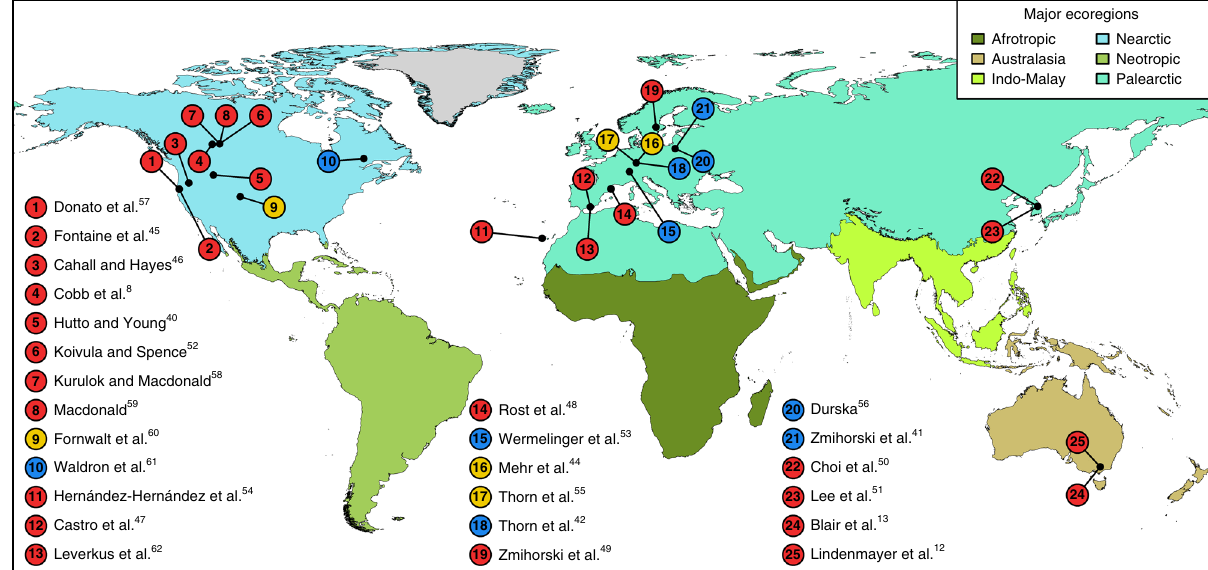
Fig. 2 Location of studies included in the present analysis. Each study provided species-by-plot abundance matrices for salvage-logged and unlogged, naturally disturbed forest plots. Disturbance types are indicated by different symbol colors (red: wild fi res, blue: windstorms, yellow: insect outbreaks; see Supplementary Table 1 for details and references). Background colors indicate major terrestrial ecoregions 67